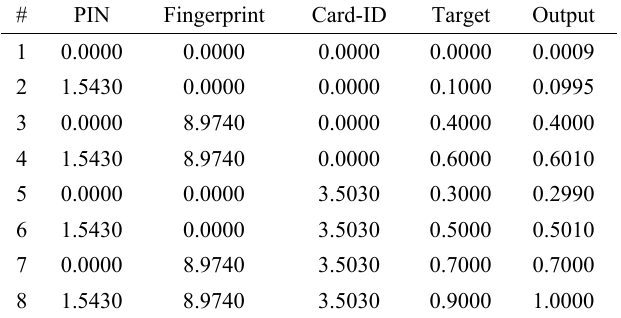
Table 11: Input values, target values and the corresponding output values generated by an adaptive neural-fuzzy inference system information fusion technique using term weight identity attributes metrics values.